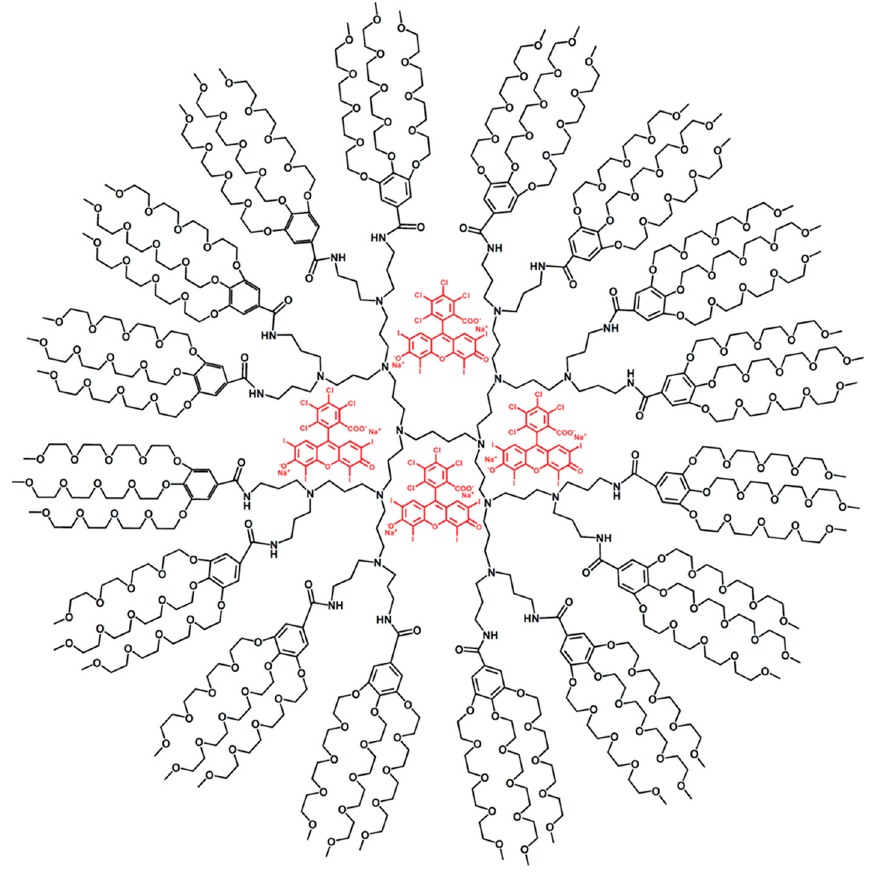
Figure 19. Poly(propylenimine) (PPI) core: PEGylated shell unimolecular micelle containing three molecules of encapsulated Rose Bengal dye. Reprinted with permission from [72]. Copyright 2000 Springer/Nature.